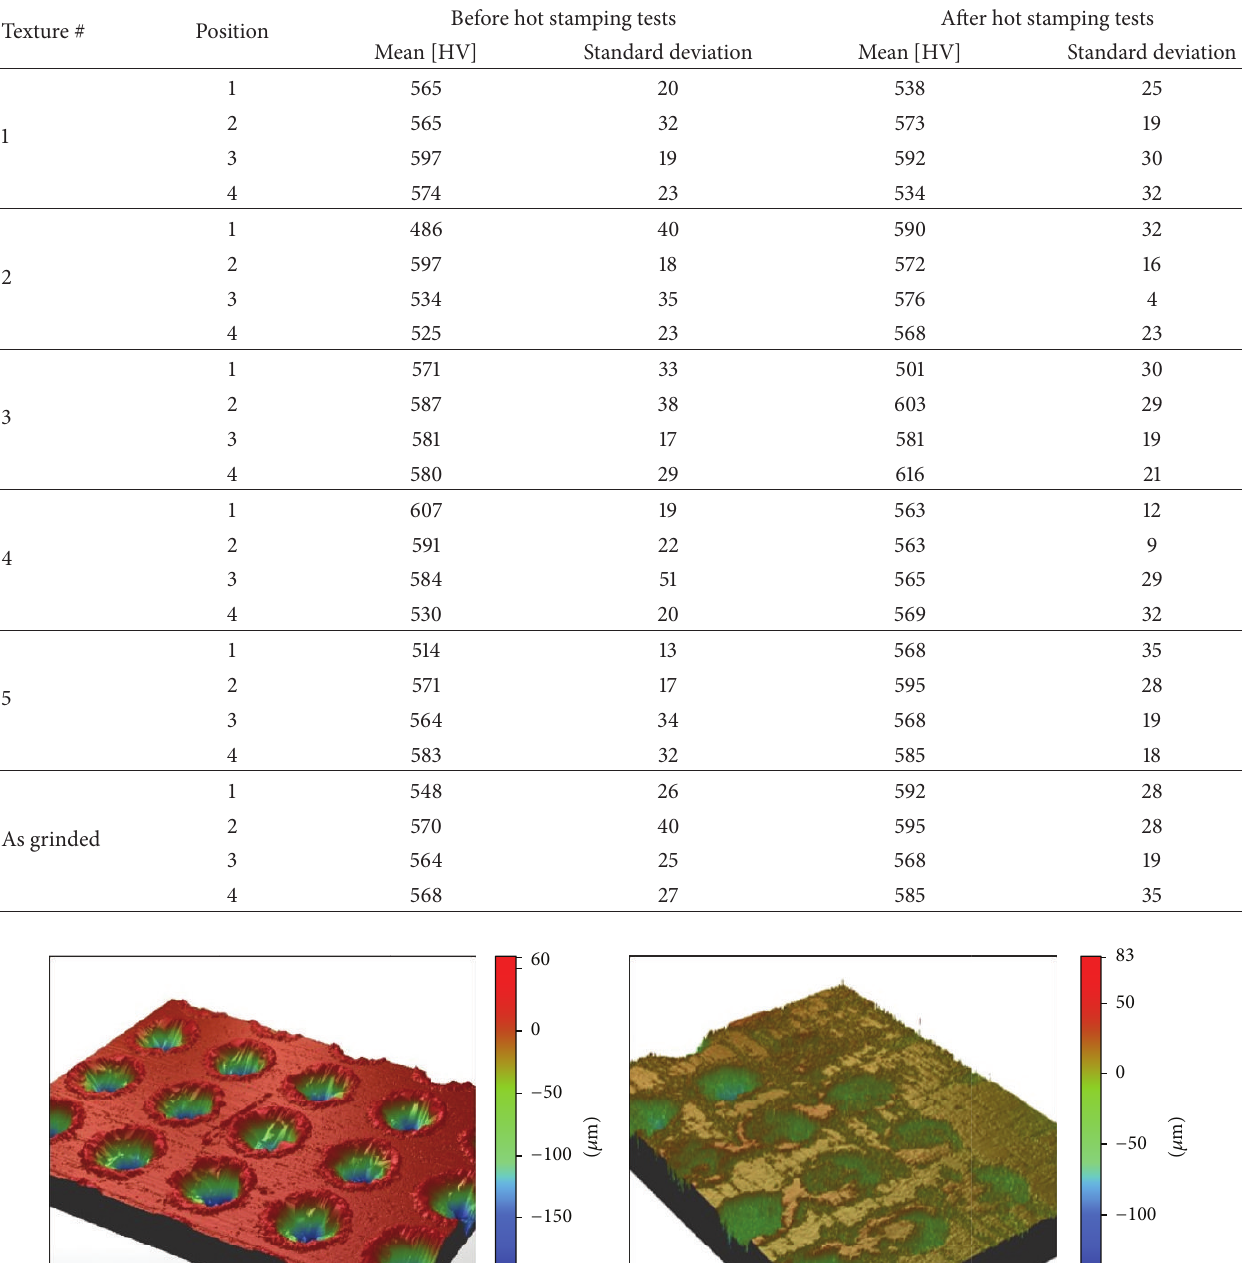
Table 3: Microhardness Vickers of all textures before and after the hot stamping tests.